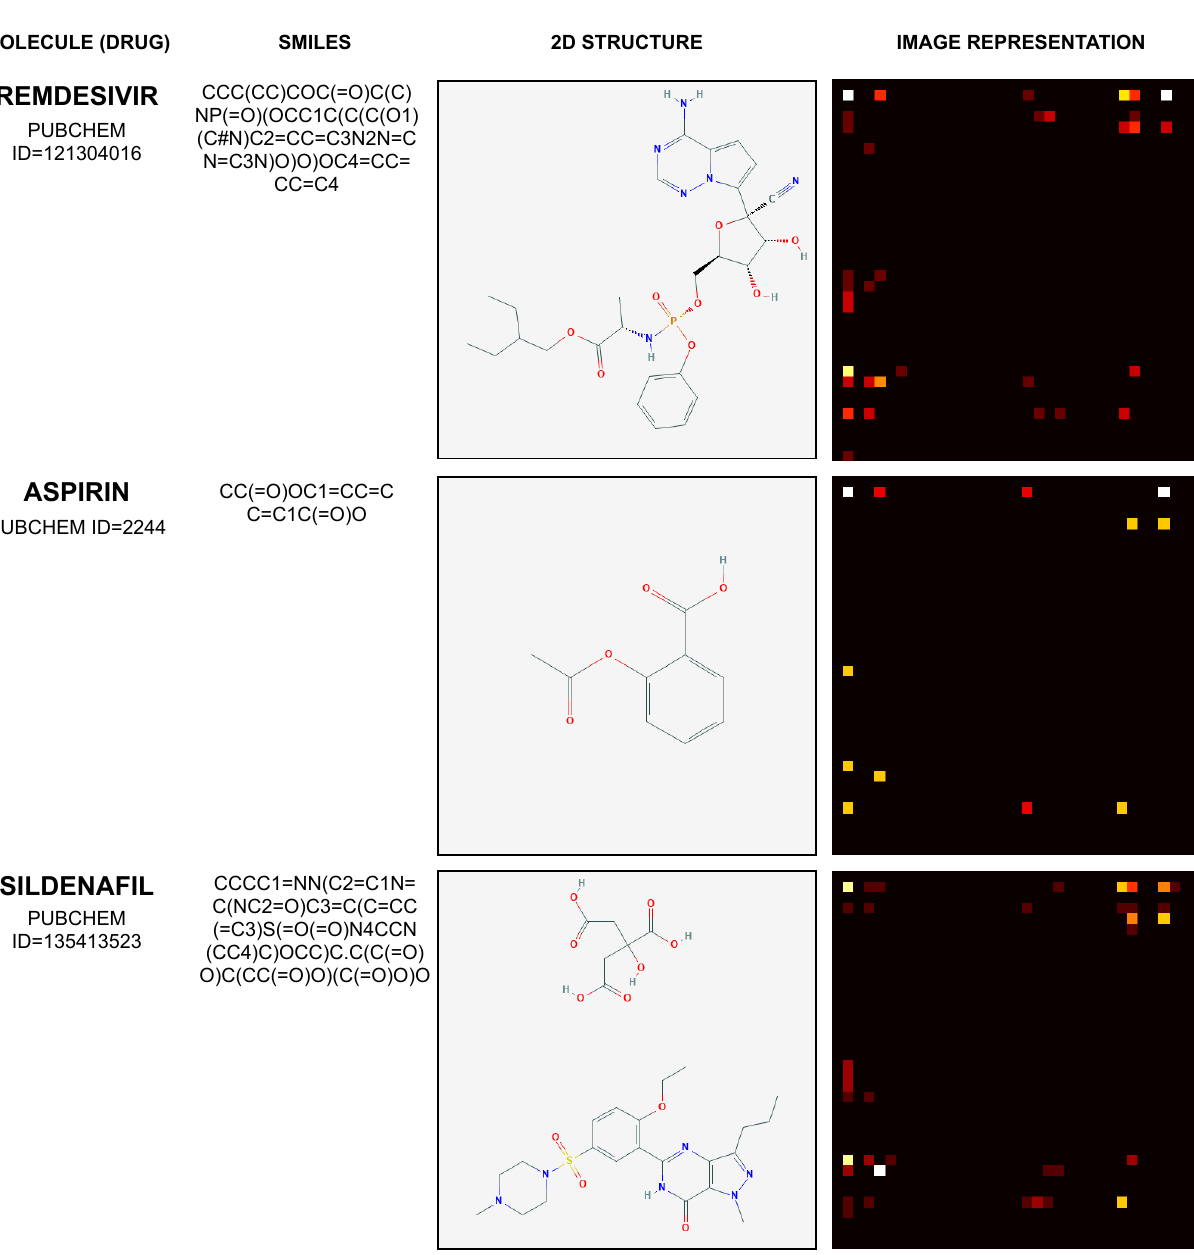
Figure 3. Example of mapping molecule sequence to image. The molecules depicted by Figure 3 and their corresponding PUBCHEM identifiers are Remdesivir (121304016), Aspirin (2244), and Sildenafil (135413523). Their 1D